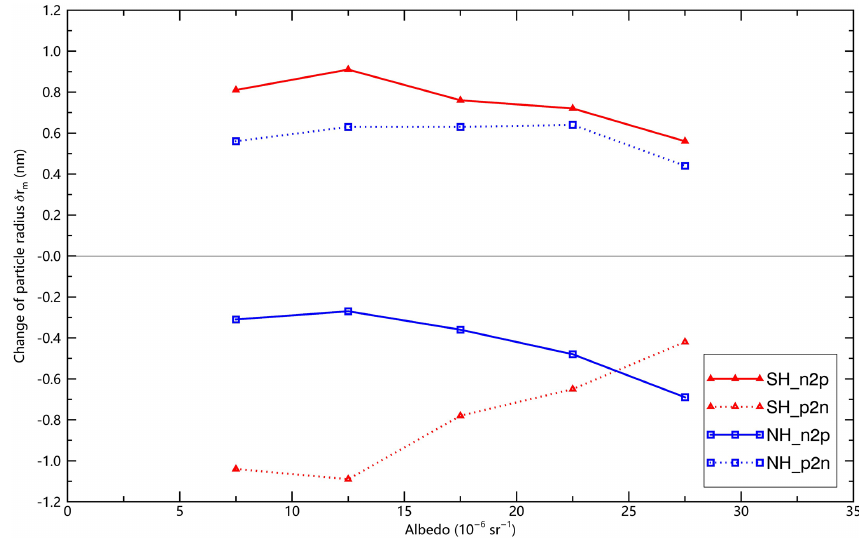
Figure 9. The influences of IMF B y reversals on the ice particle radius changes δr m at different NLC